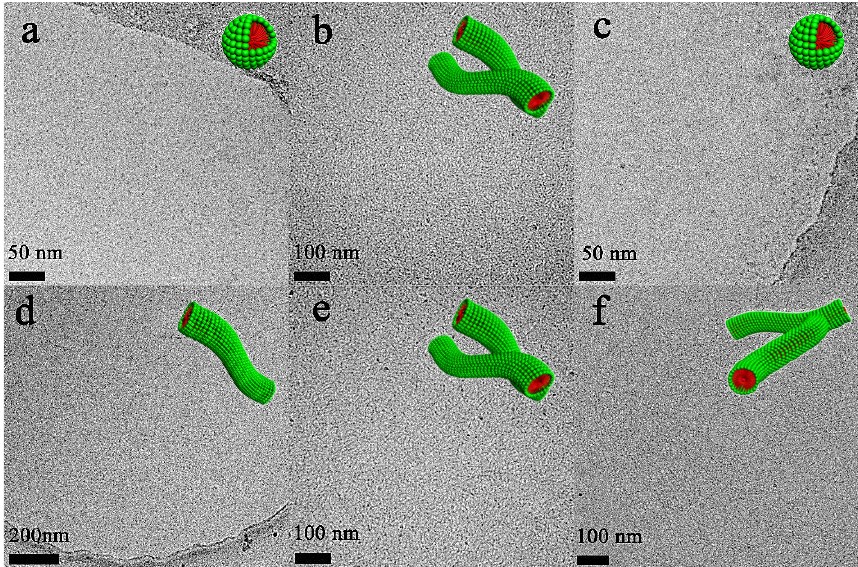
Figure 3. Cryo-TEM micrographs of the C 12 C 3 C 12 (SO 3 ) 2 and C 12 C 3 C 12 (SO 3 ) 2 /CTAB aggregates. For 20.0 mM C 12 C 3 C 12 (SO 3 ) 2 , the pH values are selected at 9.5 ( a ) and 6.7 ( b ); and for C 12 C 3 C 12 (SO 3 ) 2 /CTAB mixtures at pH 6.7, the C T values are determined at 0.1 mM ( c ), 1.0 mM ( d ), 20.0 mM ( e ) and 60.0 mM ( f ), respectively.